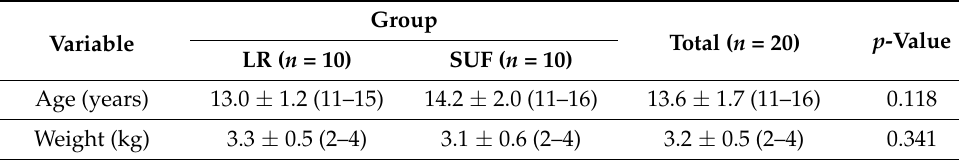
Table 1. Sample characteristics by group (LR vs. SUF).